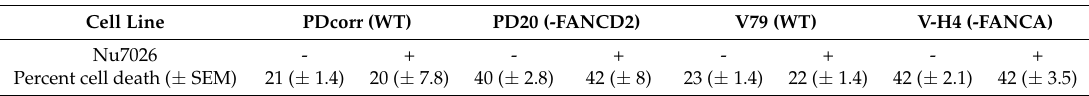
Table 1. Effect of DNA-PK inhibitor Nu7026 on 1,2,3,4-diepoxybutane (DEB)-induced cell death in human and hamster cells. Cells were exposed to DEB in the presence or absence of 10 µ M Nu7026 and the percent cell death determined as described in the Methods